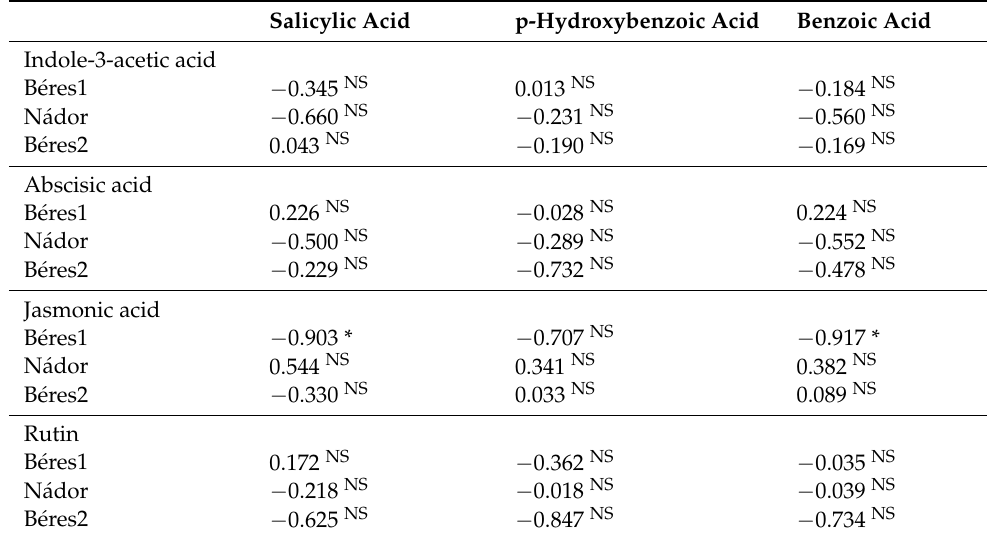
Table 6. Correlation between the metabolites present in the microalgae biomass and the metabolites extracted from microalgae biomass-applied leaves. * represents significant differences from the control at p < 0.05 and NS represents significant differences from the control at p < 0.05. Salicylic Acid p-Hydroxybenzoic Acid Benzoic